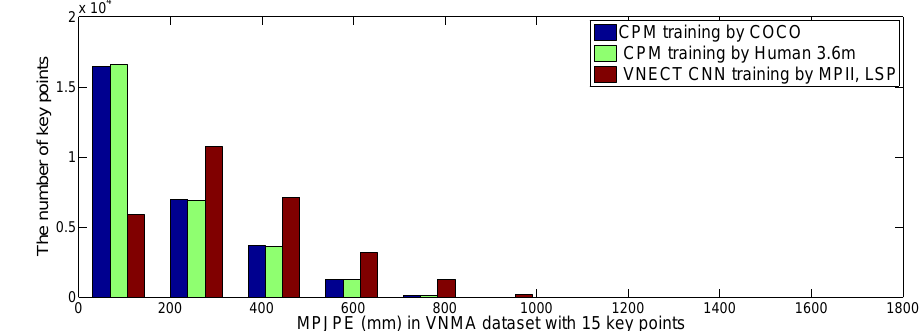
Fig. 13: Error distance distribution between key points on the 3-D ground truth data and the estimated 3-D pose data on the VNMA dataset. where: "CMP training by COCO" is "3-D_COCO_Method" , "CMP training by Human 3.6m" is "3-D_HUMAN3.6_Method", "VNECT CNN training by MPII, LSP" is "3-D_VNECT_Method".